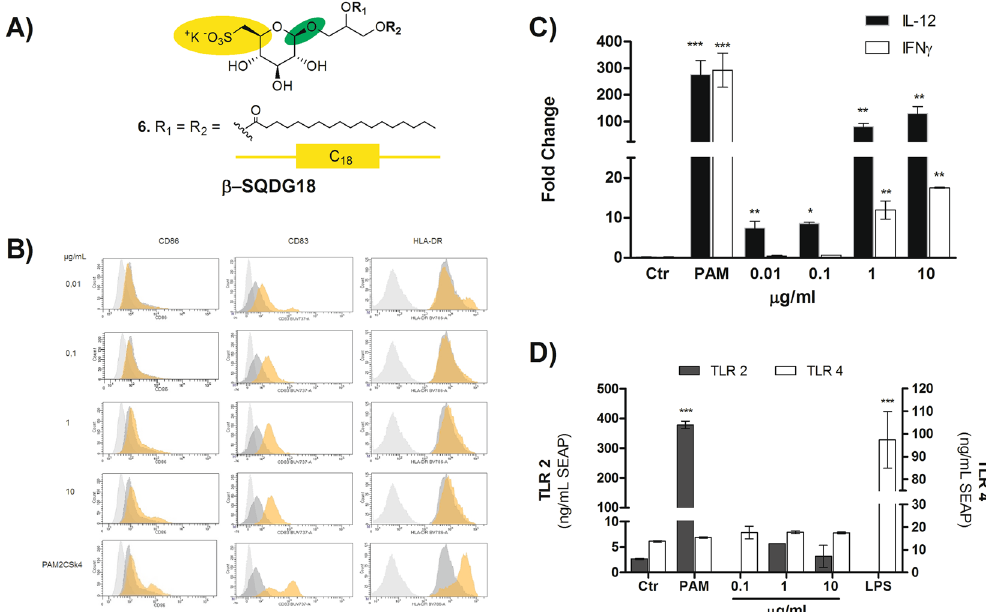
Figure 2. Dose-dependent priming of DC by β SQDG18 (6). ( A ) The chimeric molecule β -SQDG18 ( 6 ) derives from combination of the structural characteristics of α -SQDG ( yellow ) and MPLA ( green ); ( B ) Flow-cytometry analysis of the phenotyping markers of DC maturation (HLA-DR, CD83 and CD86) at concentrations between 10 ng/ml to 10 µ g/ml of β -SQDG18 ( 6 ). gray = isotype control; dark gray = unstimulated cells; orange = stimulated cells. Pam2CSK4 (PAM) was used as positive control; ( C ) expression of IL-12 and IFN- γ by DC stimulated with β -SQDG18 in the same range of concentrations used for the above marker phenotyping; ( D ) evaluation of the Toll-Like Receptor (TLR) activation by increasing concentration concentrations of β -SQDG18 in TLR-2 and TLR-4 NF-kB/SEAP reporter cell lines. Pam2CSK4 (PAM) and LPS were used as positive controls for TLR-2 and TLR-4 respectively. Asterisks indicate significant differences from the cells treated only with vehicle (control, Ctr) at a 95% (P < 0.05) confidence level, as determined using two-way ANOVA